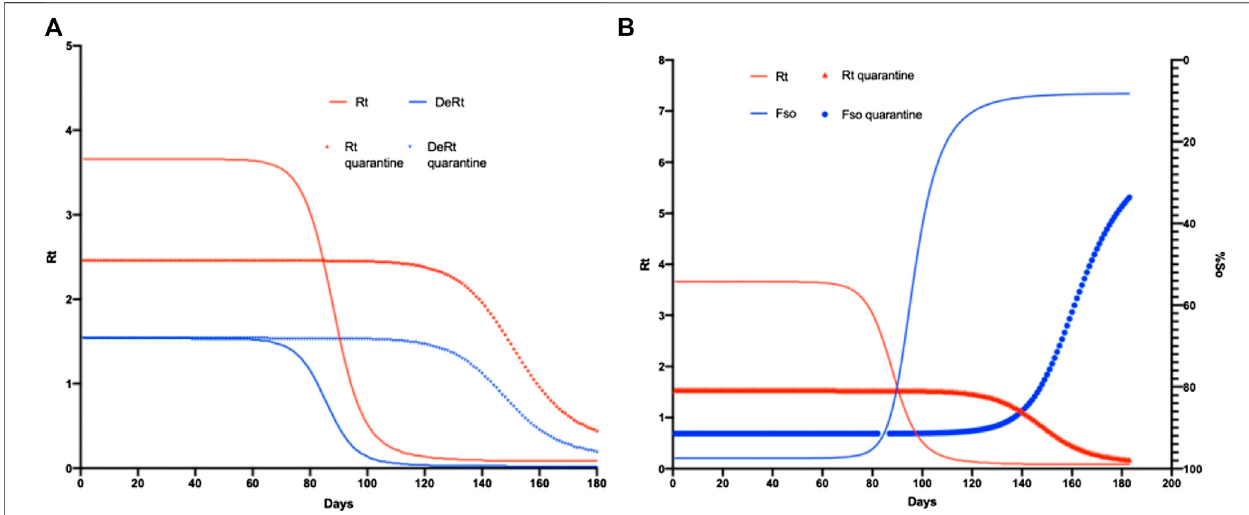
Frontiers in Applied Mathematics and Statistics |